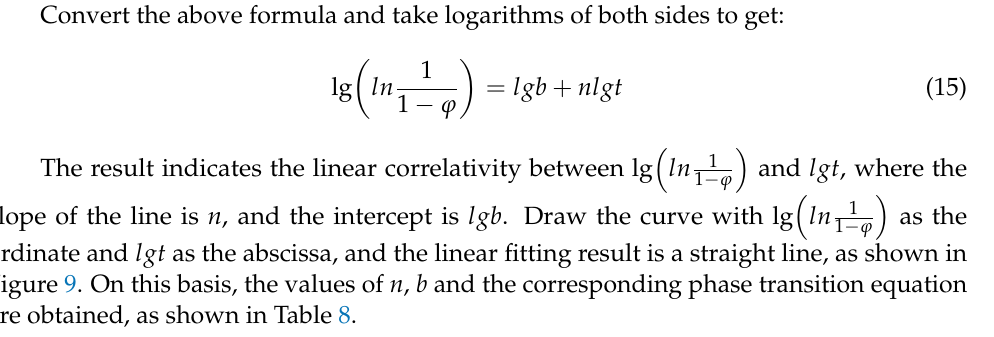
are obtained, as shown in Table